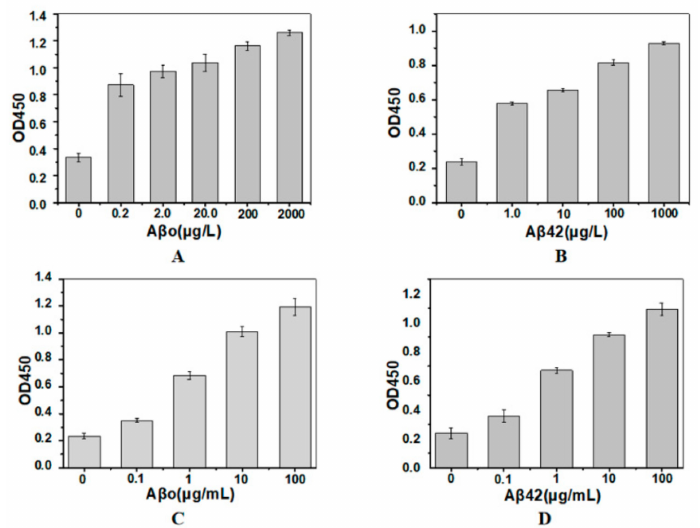
Figure 3. Sandwich immunoassay of A β o ( A , C ) and A β 42 monomer ( B , D ) in simulated cerebrospinal fluid( A , B )andserum( C , D ).ThecapturenanobodywastheimmobilizedSH2. Thedetectionnanobodies for A β o and A β 42 were His-tagged SH2 and SDP6, respectively ( n =